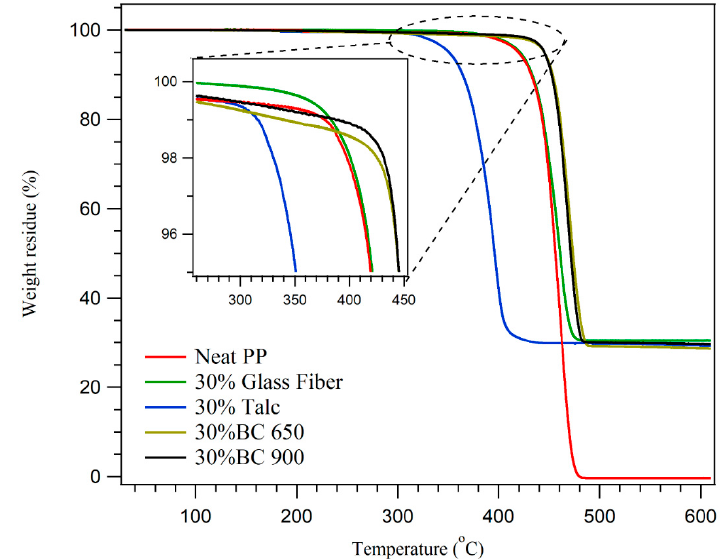
Figure 4. TGA of neat PP and PP-filler composites.